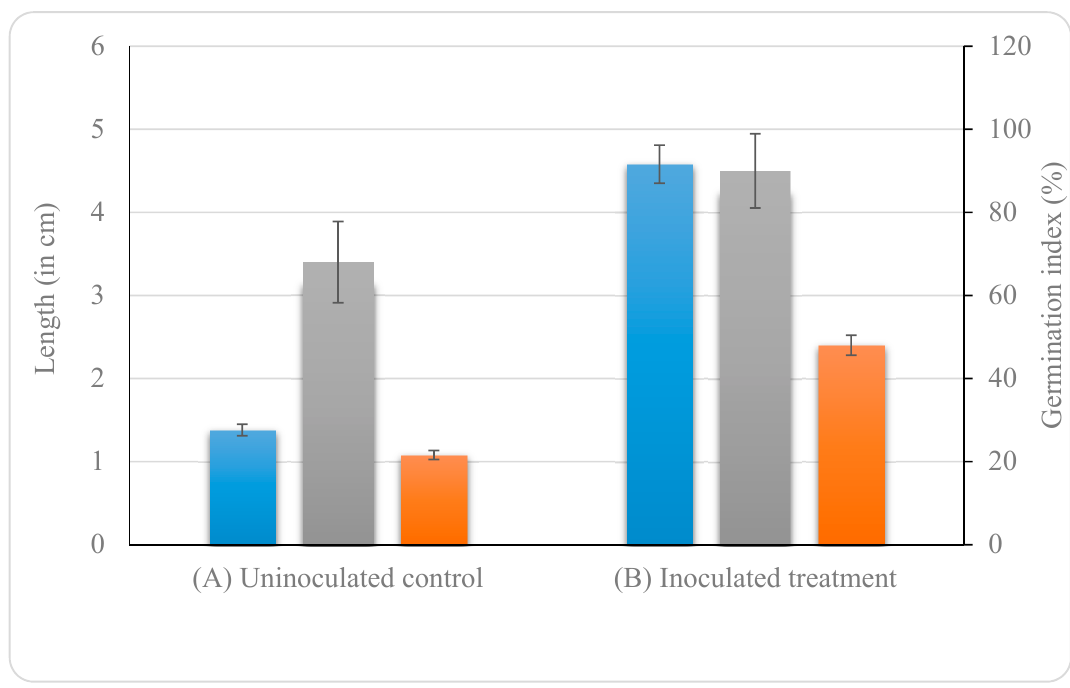
Figure 4. Effect of B. altitudinis KP-14 on germination of Brassica alba seeds: ( A ) uninoculated control and ( B ) inoculated treatment. Displayed data is the mean ± SE value of five replicates of each treatment. ( germination index